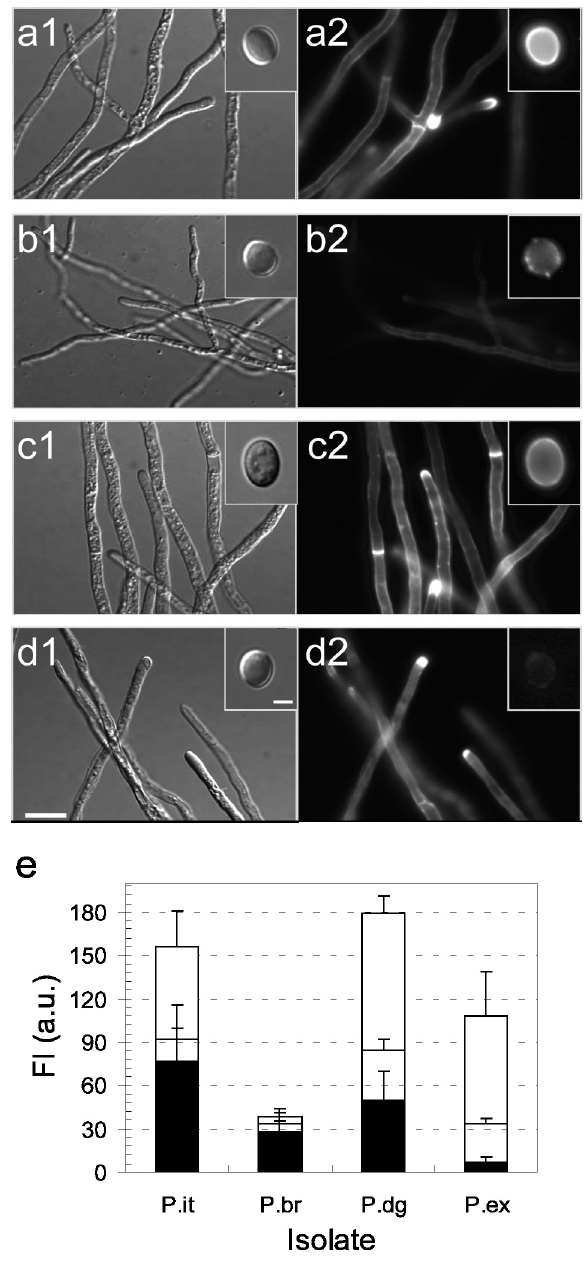
Figure 5. Microscopical visualization and fluorescence intensity quantification of conidia and mycelium of fungi stained with CFW. Samples correspond to Penicillium italicum PHI-1 (a), P. brevicompactum PHI-8 (b), P. digitatum PHI-26 (c) and P. expansum PHI-65 (d). Panels show the same area under DIC bright field (panel suffix 1) or fluo- rescence emission from CFW (panel suffix 2). Inset panels show magnified conidia of each fungus. Histogram in (e) represents the fluorescence intensity (FI) values obtained after processing of micrographs by the Image-Pro Plus 7.0 software. Piled columns show FI values ± SD for conidia (black bar), mycelium walls (striped bar) and hyphal tips (white bar) of P. italicum PHI-1 (P.it), P. brevicompactum PHI-8 (P.br), P. digitatum PHI-26 (P.dg) and P. expansum PHI-65 (P.ex) isolates. u.a. arbitrary units. Bar: 20 µm (2 µm inset